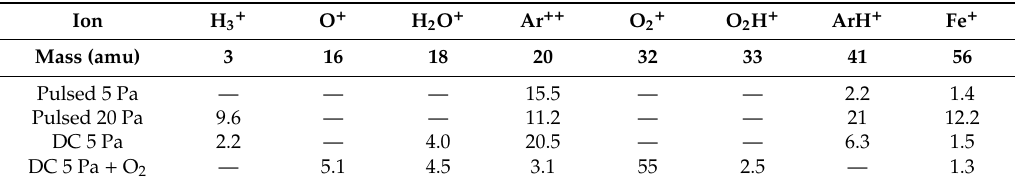
Table 1. Amplitudes of the strongest ion signal peaks in the measured mass spectra. Values are relative to that of the most abundant Ar + ion, which is set to 100%. The ion energy was set to 0.5 eV. Distance from the cathode is 7 cm, Ar flow 150 sccm, O 2 flow 3 sccm (last row only), discharge current 150 mA and pulsed mode duty cycle 10% at a frequency of 1 kHz.